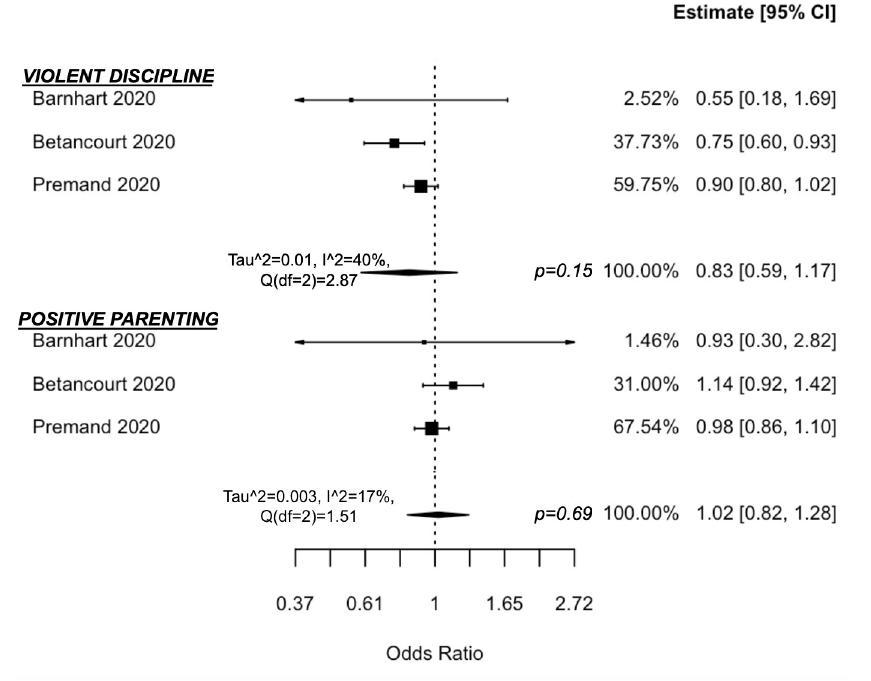
Fig 7. Forest plot of Cash + Child Protection vs. cash alone on parenting